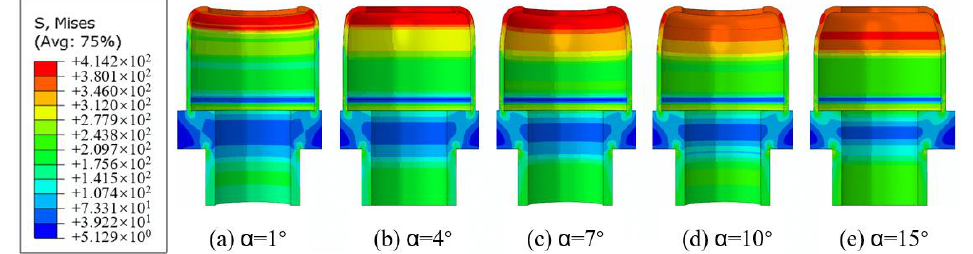
Figure 6. Effect of the nosing die’s inclination angle ( α ) on